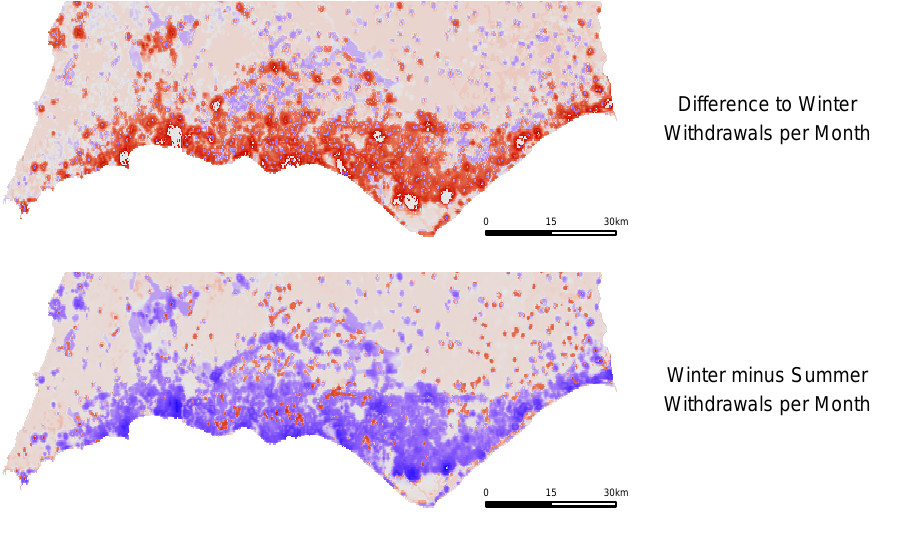
Figure 12. Difference between the disaggregated results for the variables corresponding to the number of withdrawals during summer and the number of withdrawals during